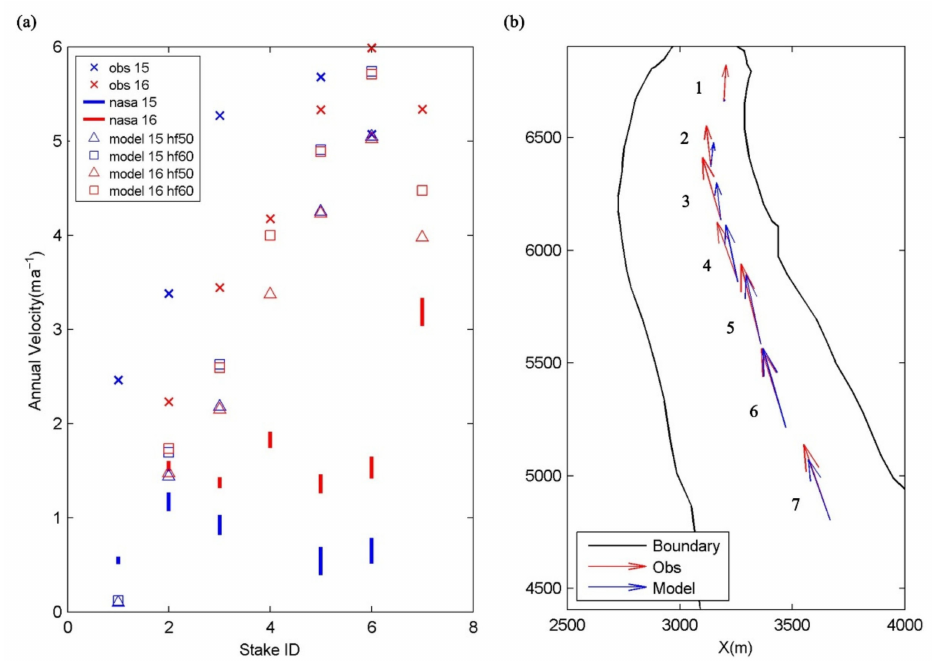
Figure 11. ( a ) The observed surface velocities at stakes (stars), best-fit modeled with geothermal heat flux of 50 (triangles) and 60 (squares) mW m − 2 (see legend hf50, hf60), and annual mean surface velocities provided by the NASA MEaSUREs ITS_LIVE project [21] satellite images (lines, see legend nasa) in the year 2015/2016 (blue) and 2016/2017 (red); ( b ) the averaged observed (red arrow) and modeled (blue arrow) surface velocities in the years 2015 and 2016 as vectors on the glacier